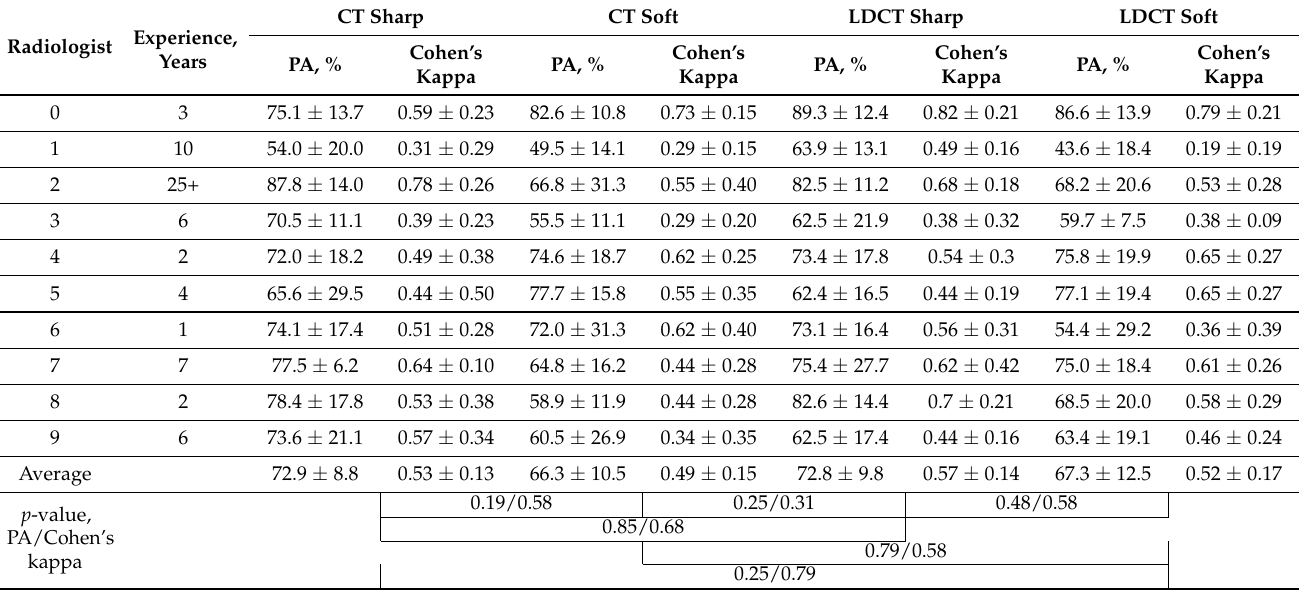
Table 2. Average inter-observer agreements for the readers in the